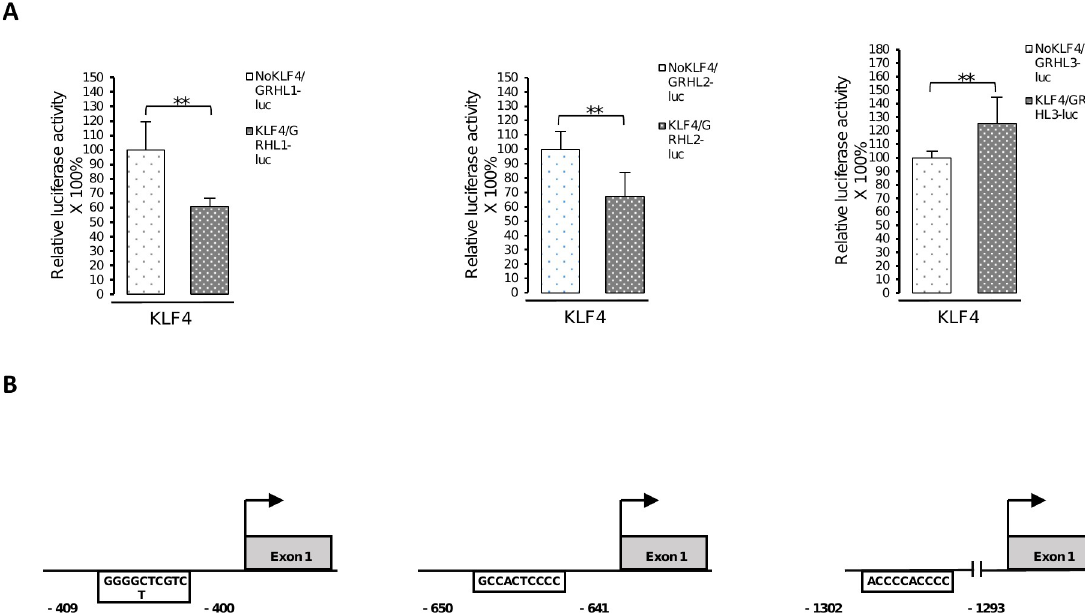
Fig 5. KLF4 changes the activity of GRHL regulatory regions. ( A ) HEK293 cells were transfected with pcDNA3.1-KLF4 plasmid, pGL3-promoter vector containing the luciferase gene under the control of the fragment of the GRHL1 or GRHL2 or GRHL3 regulatory sequence with or without binding sites for KLF4 (named: KLF4/GRHL1-3-luc or NoKLF4/GRHL1-2-luc) and pRL-CMV Renilla luciferase control reporter vector. Data are shown as means ± SEM of experiments independently performed in triplicate, � significantly different at p � 0.05, �� significantly different at p � 0.01. ( B ) Schematic representation of locations of the KLF4 binding site sequences in the promoters of GRHL1 , GRHL2 and GRHL3 genes cloned into luciferase vectors.